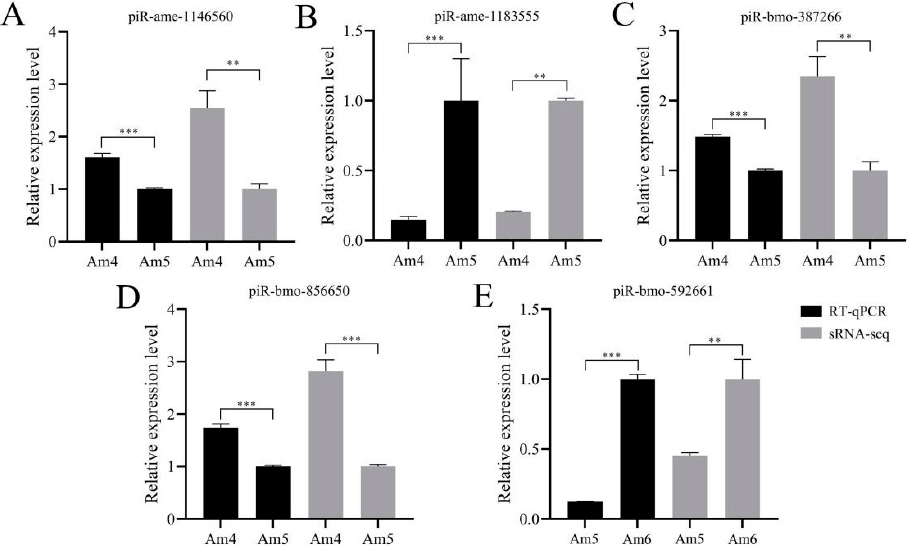
Figure 7. RT-qPCR detection of five randomly selected DEpiRNAs. The relative expression levels of the five DEpiRNAs that were detected by RT-qPCR were compared with those that were detected in sRNA-seq data. ( A – D ) Relative expression levels of piRNAs from the “Am4 vs. Am5” comparison group. ( E ) Relative expression level of piRNA from the “Am5 vs. Am6” comparison group. ** indicates p < 0.01 and *** indicates p < 0.001.